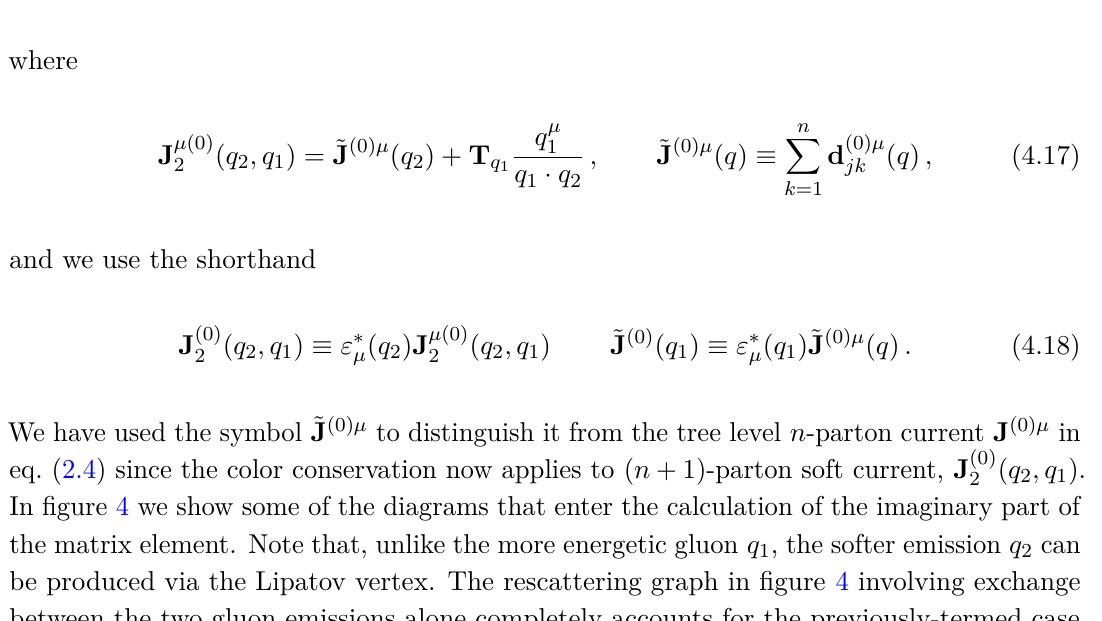
Figure 4 . One-loop Glauber exchange diagrams in low energy EFT with an additional soft emission. The solid line represents an offshell mode that has been integrated